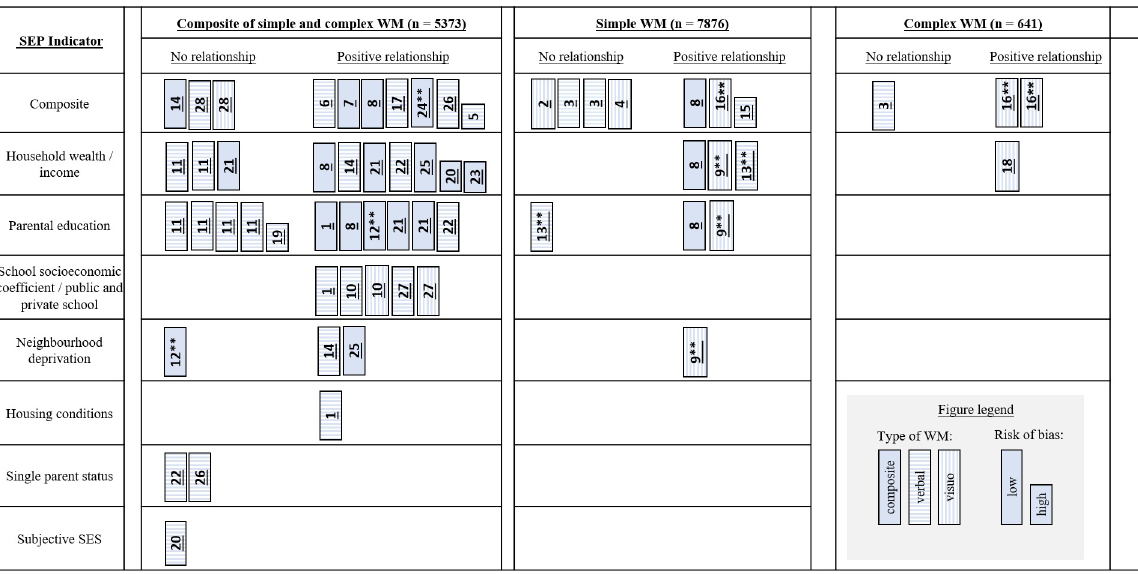
Fig 7. Harvest plot of the association between different socioeconomic position indicators with composite working memory, simple working memory, and complex working memory. Note: Study IDs are indicated on each bar as follows: 1. Aran-Filippetti & Richard De Minzi, 2012; 2. Brito et al., 2021; 3. Cockcroft, 2016; 4. Daubert and Ramani, 2020; 5. Dicataldo and Roch, 2020; 6. Dilworth-Bart, 2012; 7. Farah et al. 2006; 8. Fernald et al., 2011; 9. Flouri et al., 2019; 10. Guerra et al., 2020; 11. Hou et al., 2020; 12. Hackman et al. 2014 �� ; 13. Hackman et al. 2015 �� ; 14. He and Yin, 2016; 15. Jacobsen et al. 2017;16. Kobrosly et al. 2011; 17. Korecky-Kroll et al., 2019; 18. Leonard et al. 2015; 19. Maguire and Schneider, 2019; 20. Miconi et al. 2019; 21. Murtaza et al., 2019; 22. Passareli-Carrazzoni et al. 2018; 23. Piccolo et al. 2019; 24. Rhoades, 2012 �� ; 25. Rowe et al. 2016; 26.Sarsour et al. 2011; 27. Tine, 2014; 28. Vandenbroucke et al. 2016. The plot bar lengths indicate whether the study was at low or high risk of bias. A double asterisk �� indicates a cohort or longitudinal study.